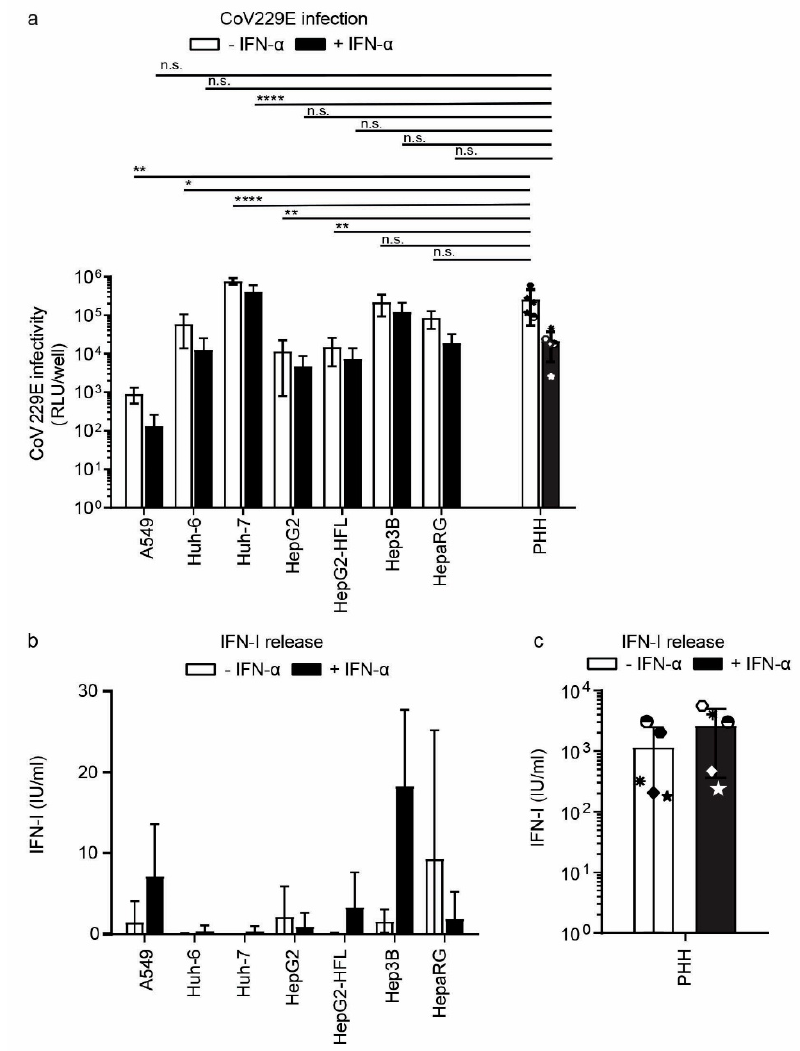
Figure 6. Susceptibility and IFN response of PHH and hepatoma cells to CoV229E. ( a ) CoV infection in PHH and hepatoma cell lines. Cells were mock-treated or pretreated with IFN- α for 24 h and subsequently infected with CoV Renilla reporter virus (MOI 0.1) for 24 h. Infection with the reporter virus was determined 24 h post-infection by measuring luciferase activity. ( b ) IFN-I secretion from hepatoma cell lines and PHH ( c ) mock-treated or pretreated with IFN- α for 24 h followed by CoV infection. Released IFN was measured as described in Figure 5. Data for the five different PHH donors are shown as mean ± SD of a single experiment performed in technical duplicates and for the cell lines as mean ± SD of three independent experiments (performed in technical triplicates). Two-way ANOVA, followed by Dunnett’s multiple comparison test * p < 0.05, ** p < 0.01, **** p <